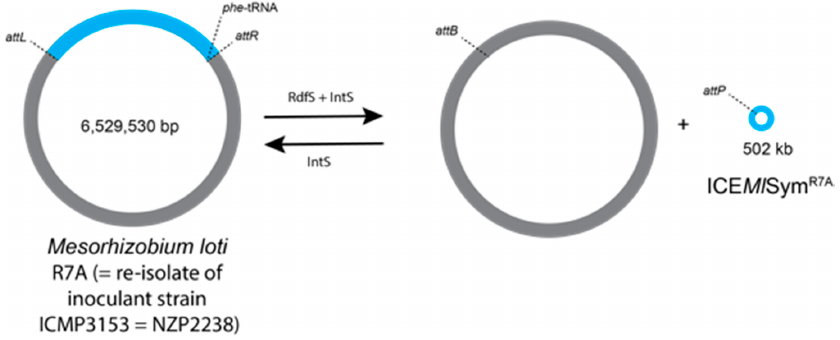
Figure 2. Recombination and circularization of Mesorhizobium loti R7A integrative and conjugative elements (ICE Ml Sym R7A ) [20,119–121]. The recombination is initiated by IntS (integration factor S) at the attachment sites attB and attP to integrate the ICE Ml Sym R7A in the chromosome and produce the attachment sites attL and attR . The recombination directionality factor S (RdfS) together with IntS stimulates excision of the ICE and forms the attachment sites attP and attB . phe-tRNA = phenylalanine transfer RNA. The ICE Ml Sym R7A is coloured blue, and the remaining chromosome is coloured grey. The schematic diagram is not drawn to